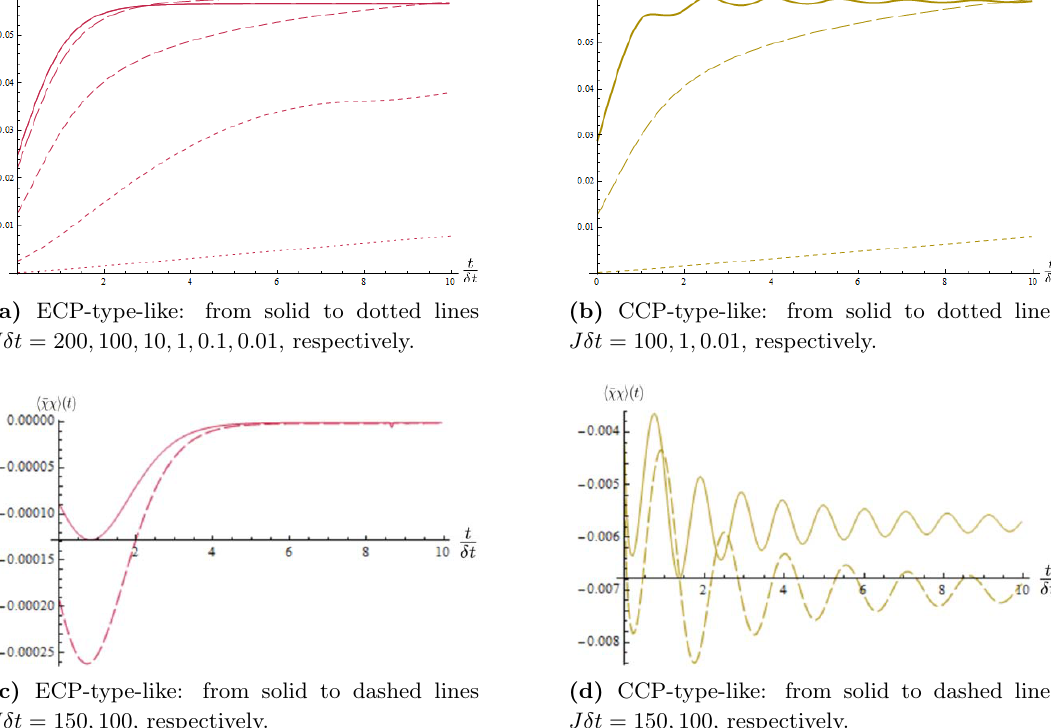
(1) ( t ) in ECP and CCP-like potentials; 6c & 6d: C